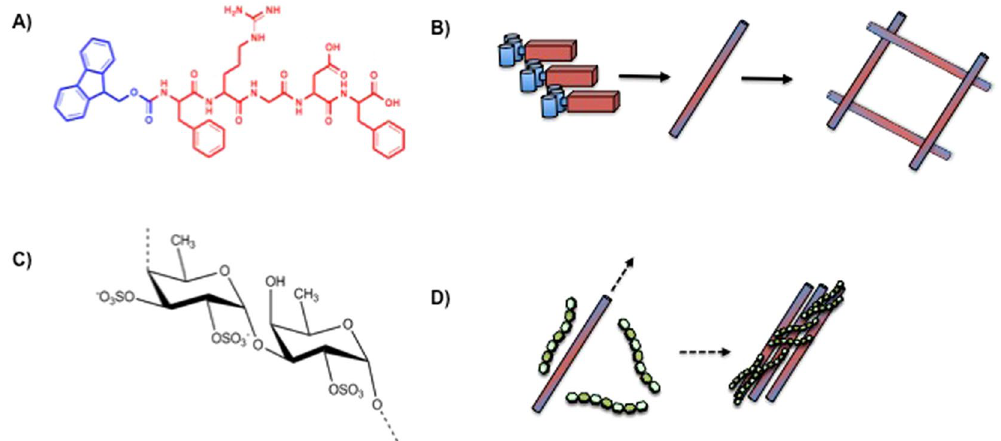
Figure 1. Peptide self-assembly: ( A ) structure of Fmoc-FRGDF. ( B ) schematic of the assembly process where individual peptides form fibrils which become entangled to form the hydrogel matrix. ( C ) repeating unit of fucoidan ( D ) Schematic of proposed induction of supramolecular ordering by interaction between fucoidan and individual fibrils to yield thicker